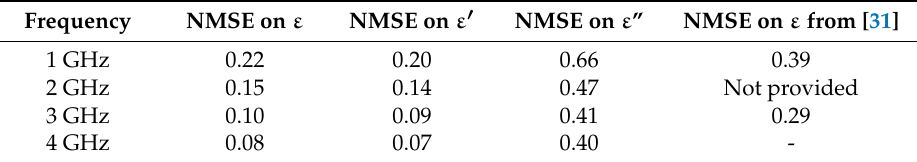
Table 2. NMSE of very dense breast (ID